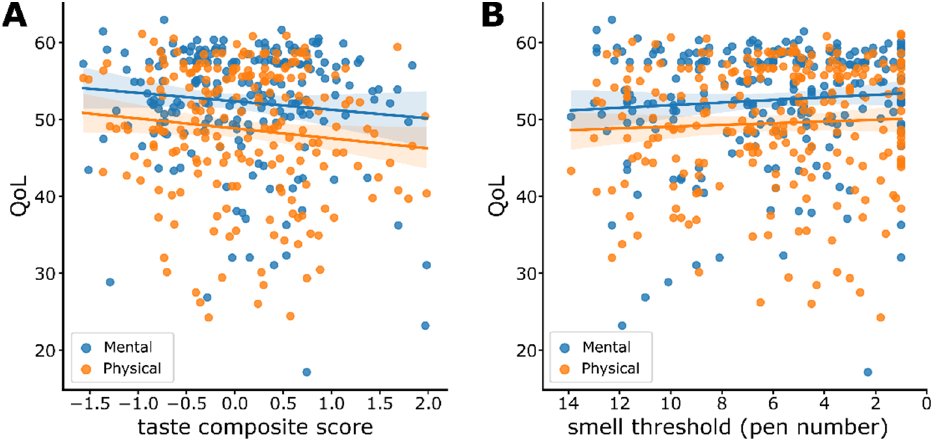
Figure 6. ( A ) Scatter plot to show the relationship between Quality of Life (QoL) and taste composite scores. A linear regression line was fitted separately for each component of QoL (mental and physical). ( B ) Scatter plot to show the relationship between QoL and smell thresholds. A linear regression line was fitted separately for each facet of QoL (mental and physical). Shaded regions show 95% CI. Each dot represents an individual’s data point.